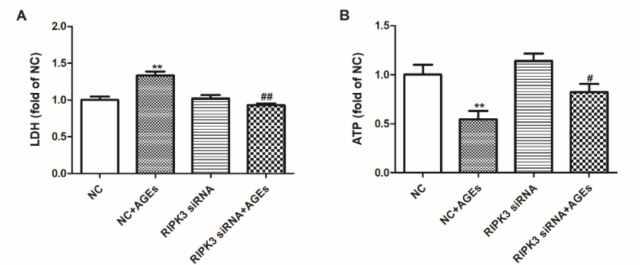
Figure 6. Downregulation of RIPK3 attenuated cell damage in cardiomyocytes. Cardiomyocytes were transfected with RIPK3 siRNA for 4 h followed by 200 µ g/mL AGEs stimulation for 24 h. ( A ) LDH release into the culture medium was detected by LDH Cytotoxicity Assay Kit. ( B ) Cellular ATP level was detected by CellTiter-Lumi™ Luminescent Cell Viability Assay Kit. Plots represent the mean ± SEM; n = 6. Statistical significance: ** p < 0.01 compared with NC; # p < 0.05, ## p < 0.01 compared with